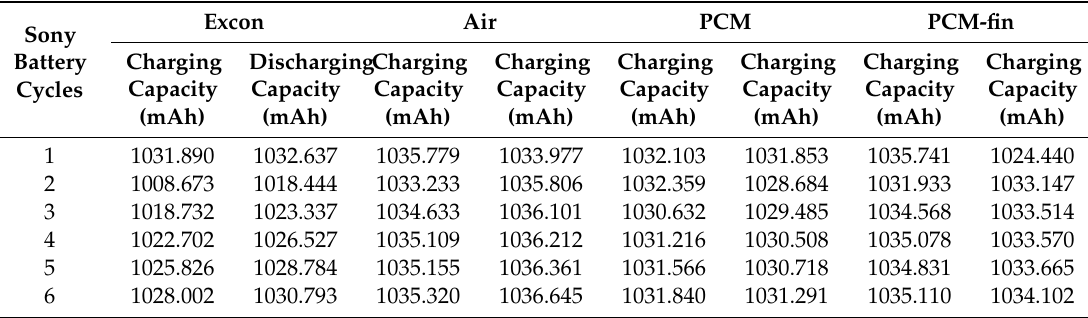
Table 5. Capacity curve of LiFePO 4 LIB in charge and discharge